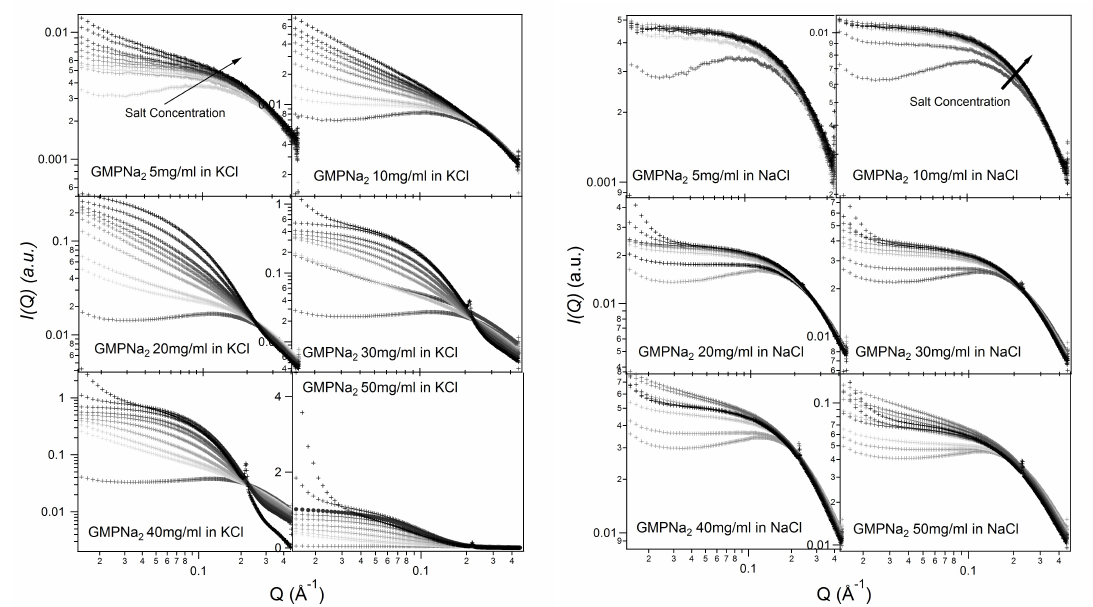
Figure 2. SAXS profiles for GMPNa 2 in KCl and NaCl solutions at 24 ◦ C. In each frame, GMP concentration is reported. The grey color of the lines is related to the salt molarity of the solution, that increases, as the arrow indicates, from 0.06 M up to 1.0